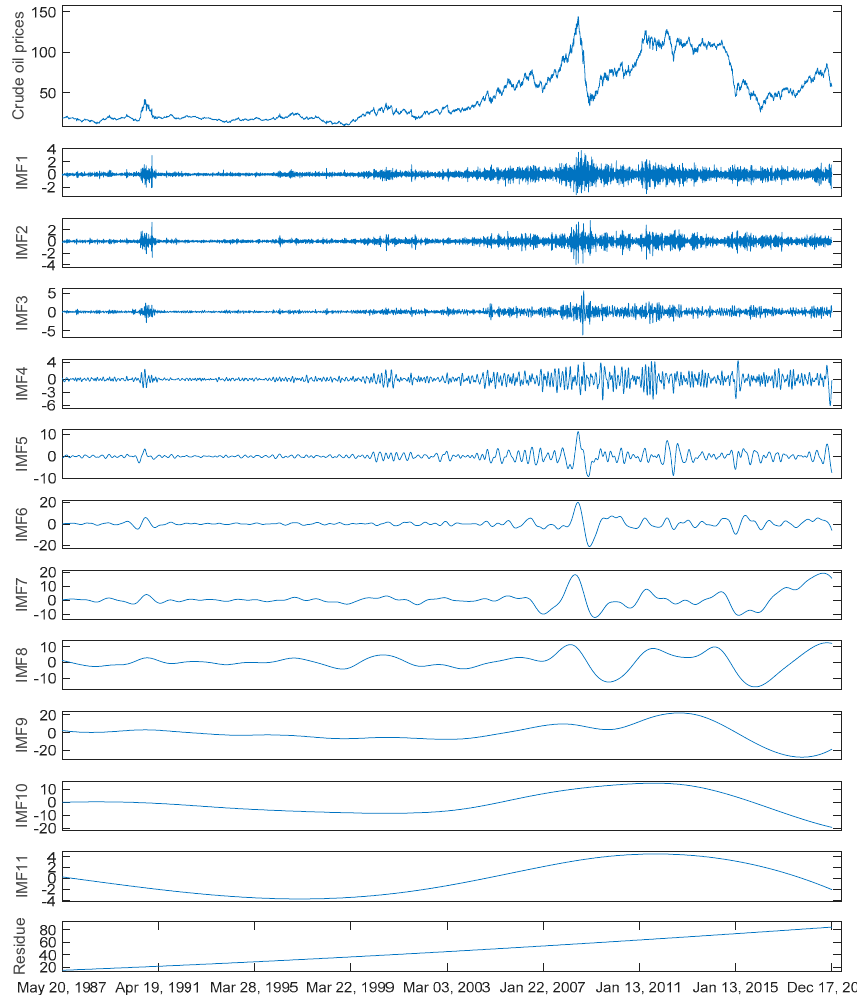
Figure 3. The original series and corresponding components decomposed by CEEMD of Brent crude oil prices.